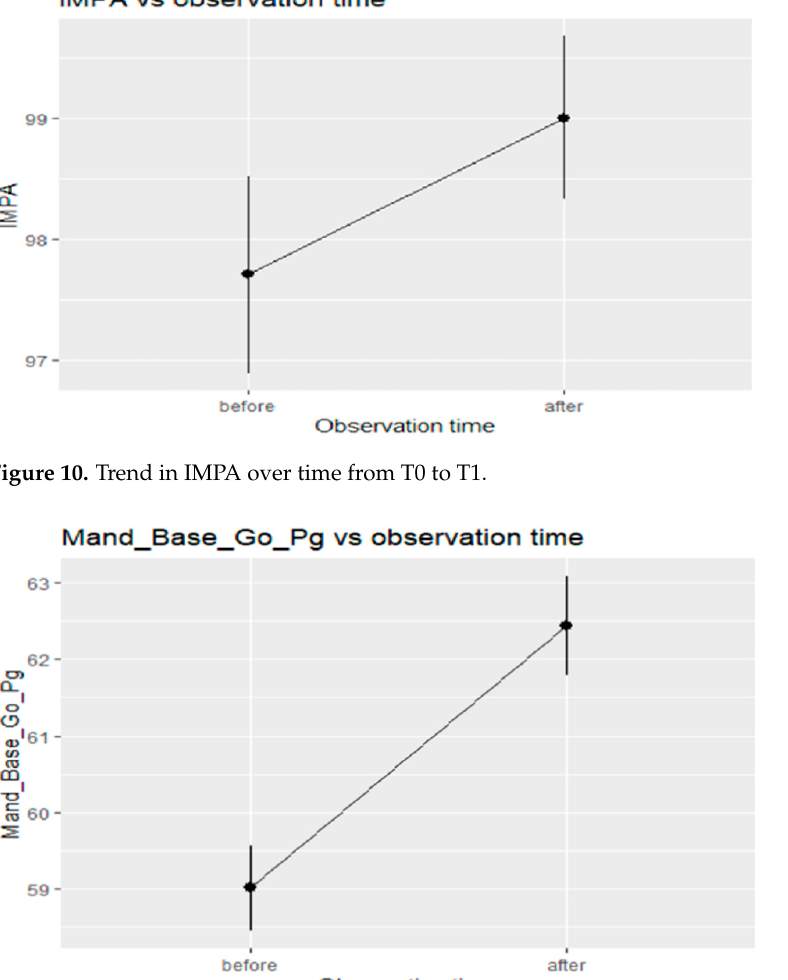
Figure 12. Trend in Co-Gn over time from T0 to T1. 5. Discussion Functional treatment of growing patients with class II malocclusion can lead to sig- nificant skeletal and dentoalveolar changes when carried out near the peak of growth. This study shows the results of treatment with F22 ® . Young for the correction of class II malocclusion in a group of patients at stage CSV3–CSV4. Before treatment, the 15 patients had an average age of 10.3 years, but were highly compliant, wearing the device for 15/20 h per day for an average total period of 10 months ± 0.5 (maximum 11.5 months, minimum 10.5 months). Even if it’s possible to start the mandibular advancement with RPE still bonded, T0 records were collected after its removal, in order to analyze just the mandib- ular advancement benefits with normalized transversal diameters. The resulting improve- ments in overjet and overbite, and the correction of the molar class on both the right and left sides, are indicators of how effective the device is in resolving class II malocclusion, providing significant normalization of dental parameters.